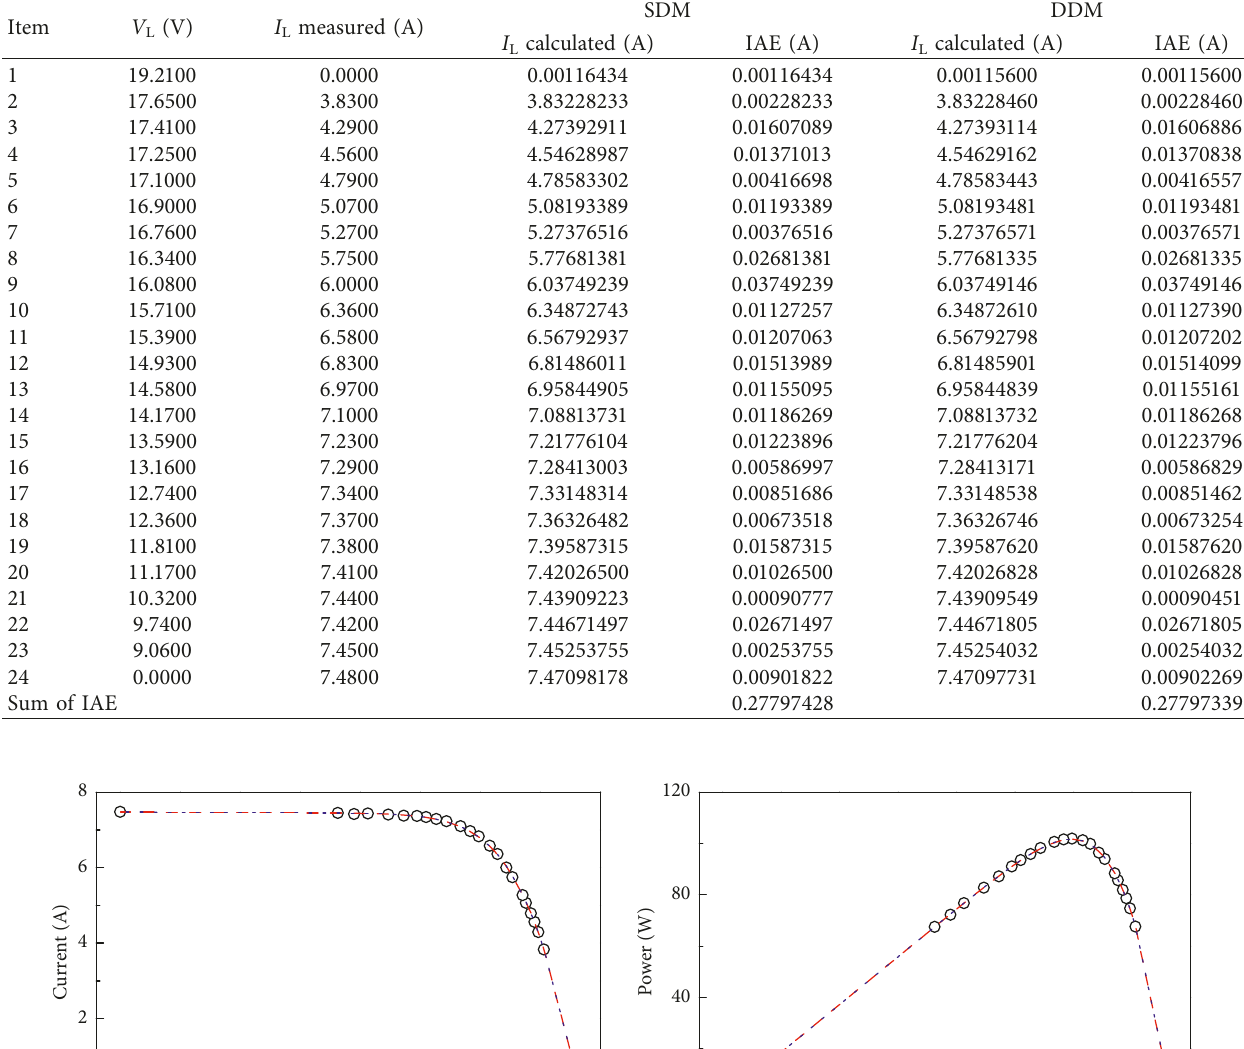
Table 14: Calculated results for the STP6-120/36 module by SDO.